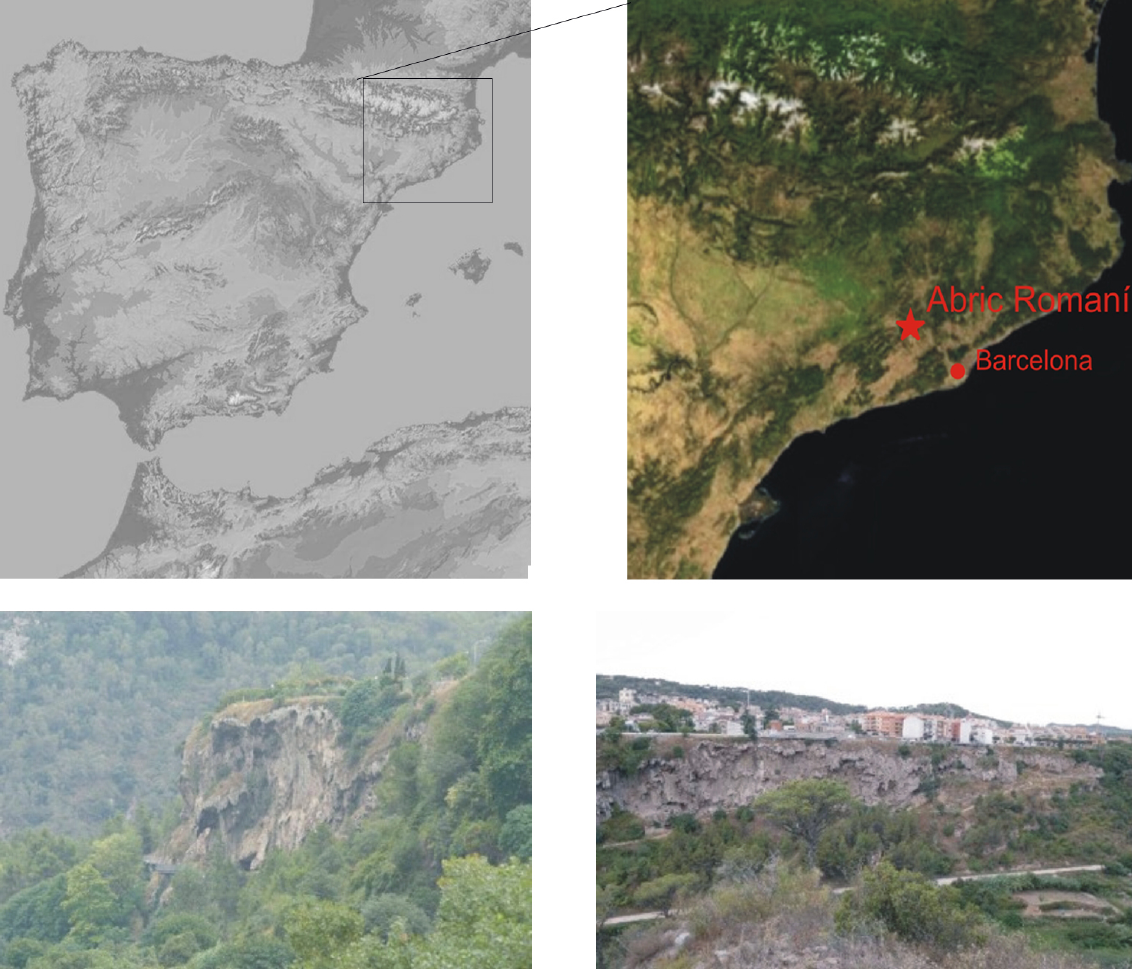
Figure 8. A) Localization of the Abric Romaní site B) General views of the Cinglera del